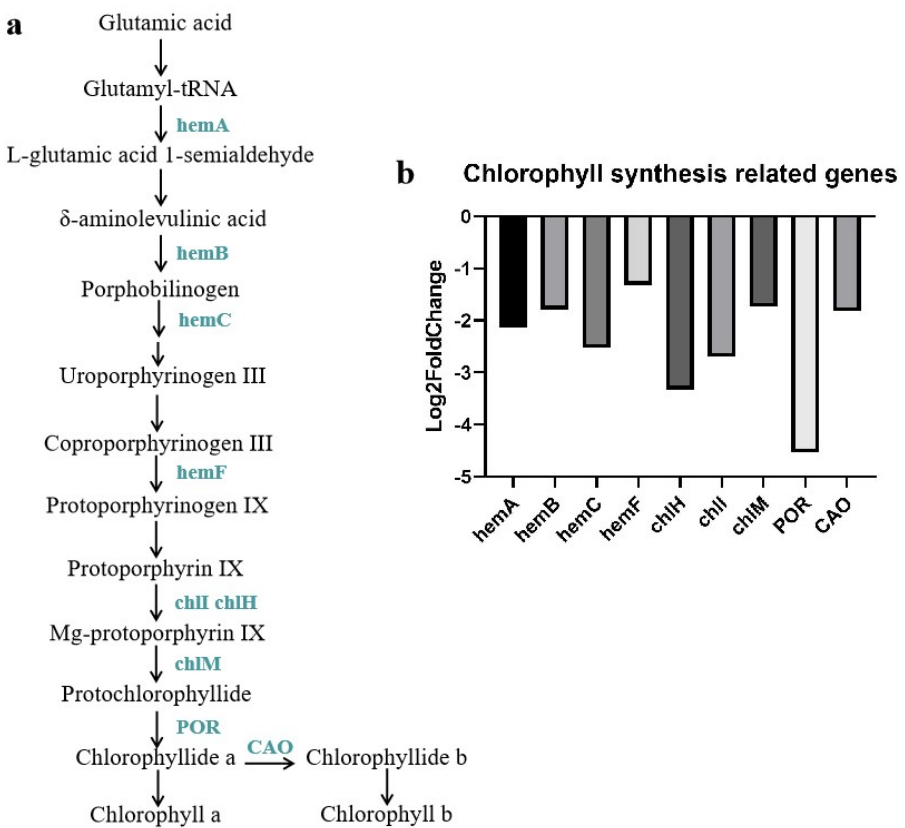
Figure 5. DEGs in chlorophyll synthetic pathway. ( a ) Flowchart showing chlorophyll synthetic pathway: Genes in blue indicated a down-regulation in B214. ( b ) Gene expression ratio B214/B227 represented using Log2FoldChange. X -axis represents the names of genes and y -axis represents the value of Log2FoldChange.